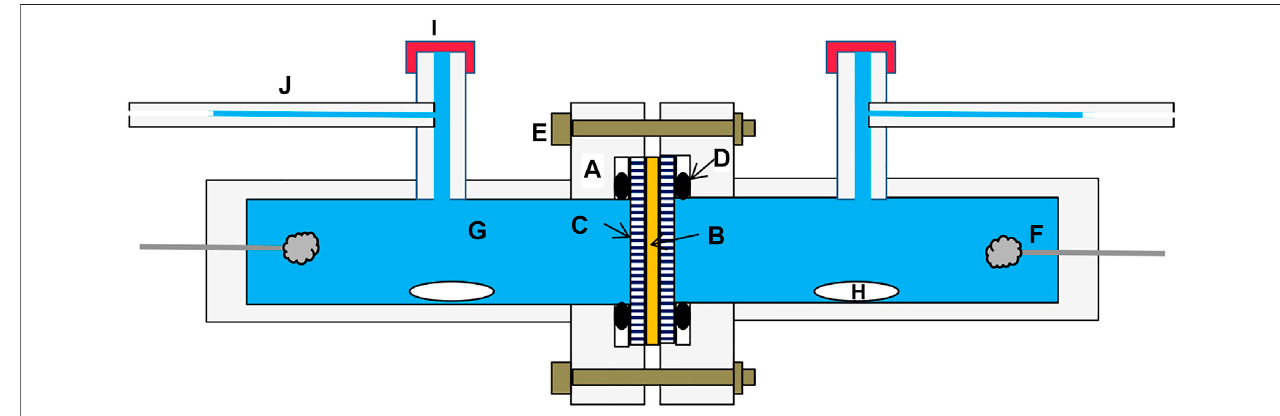
FIGURE 2 | Scheme of the electro-osmotic cell. A, plexiglass cell; B, membrane; C, perforated plate; D, o ’ ring; E, bolt; F, Ag/AgCl electrode; G, HCl solution; H, stirrer; I, septum; J, capillary tube.